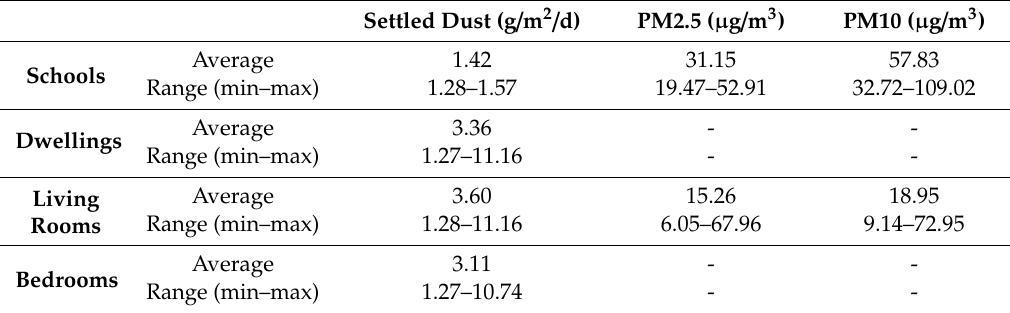
Table 2. Settled dust (g / m 2 / d) and PM2.5 and PM10 concentrations ( µ g / m 3 ) measured in dwellings and schools.